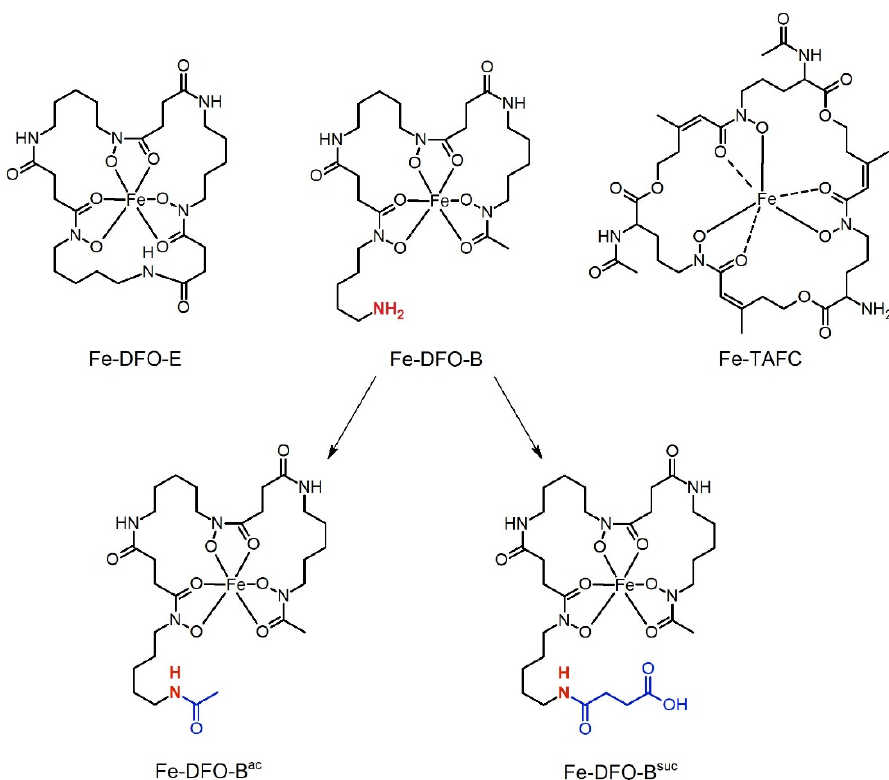
Figure 1. Chemical structures of ferric DFO-E, DFO-B and TAFC, as well as chemically modified DFO-B derivatives DFO-B ac and DFO-B suc . Chemical modifications of the amino group (in red) are shown in blue.